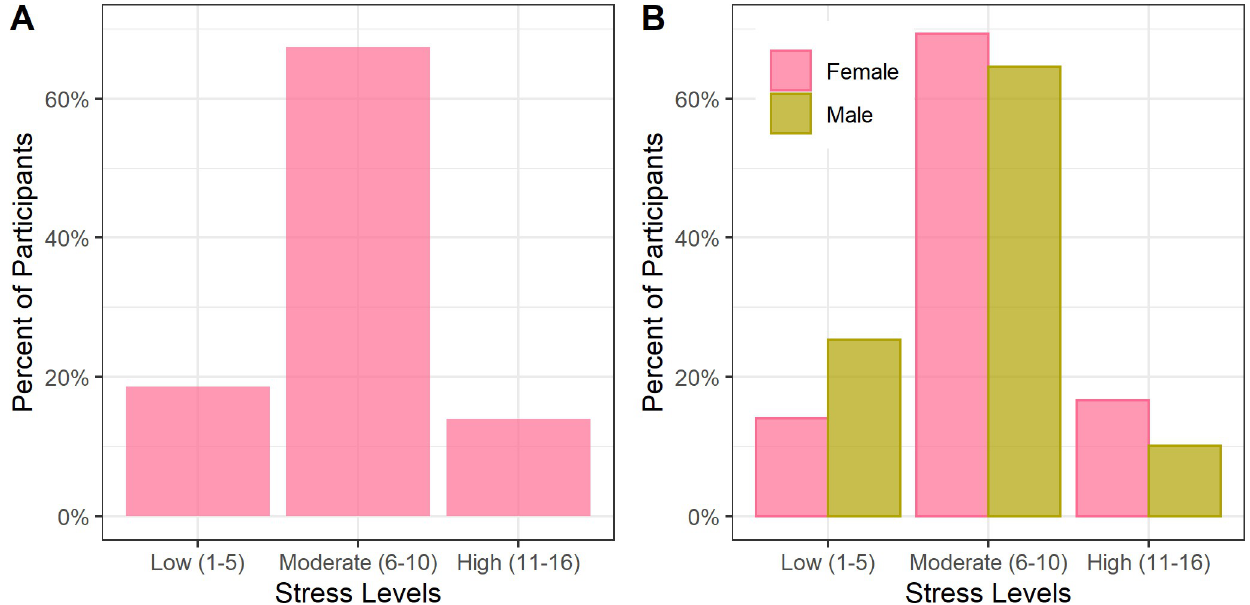
Fig 1. Moderate perceived stress among adult cohort in Haiti (N = 2817). Legend: The percent of participants in each stress level is shown in Panel A. The percent of participants by sex in each stress level is shown in Panel B. Moderate levels of stress were seen overall, with lower stress in men versus women.